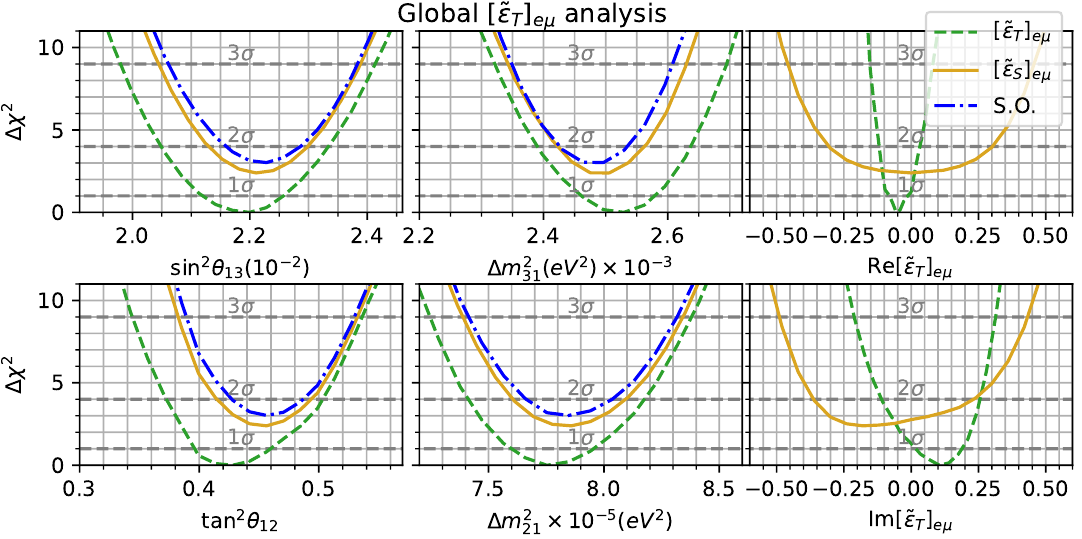
(b) The same as before, but for the global analysis, MBR, KamLand, and sun. Figure 4 . Results for ∆ χ 2 for sun+KamLand and for the global